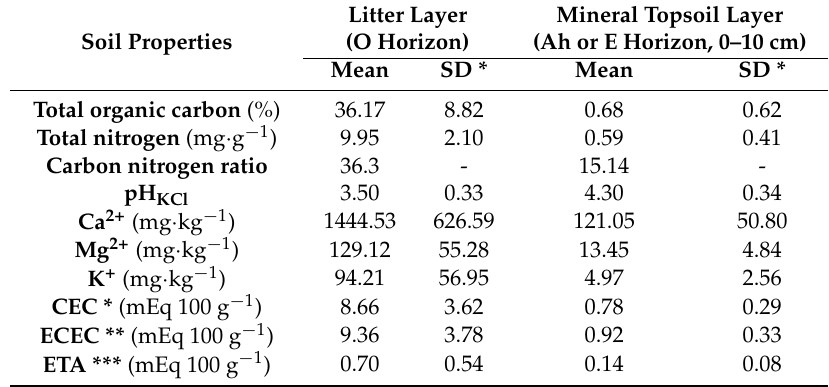
Table 4. Soil properties of the litter layer (O horizon) and mineral topsoil layer in sampled gaps.